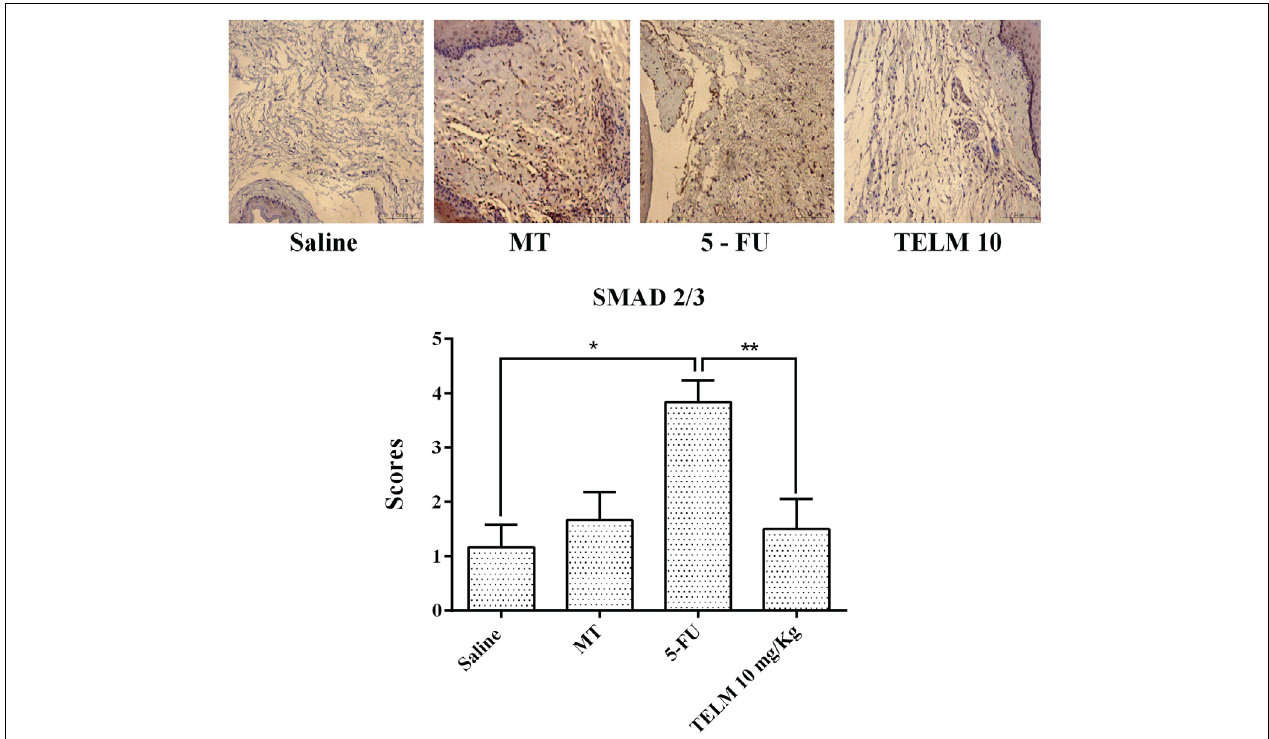
FIGURE 5 | Immunohistochemistry and scores for Smad 2/3. The saline group and the mechanical trauma (MT) group had little immunostaining. The inflammatory cells and fibroblasts of the jugal mucosa of the 5-FU group were intensely labeled Smad 2/3 compared to the saline group. TELM at 10 mg/kg reduced the immunostaining for Smad 2/3, compared to the 5-FU group. The scores are represented as the medians ± standard error of the mean ( n = 5). ∗ p < 0.05 vs. the saline group, ∗∗ p < 0.05 vs. the 5-FU group (Kruskal–Wallis test and Dunn’s multiple comparison test).